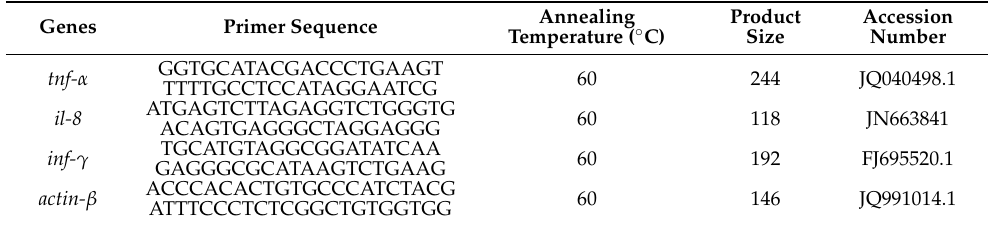
Table 2. Primer sequence, annealing temperature, product size, and accession number of selected genes.